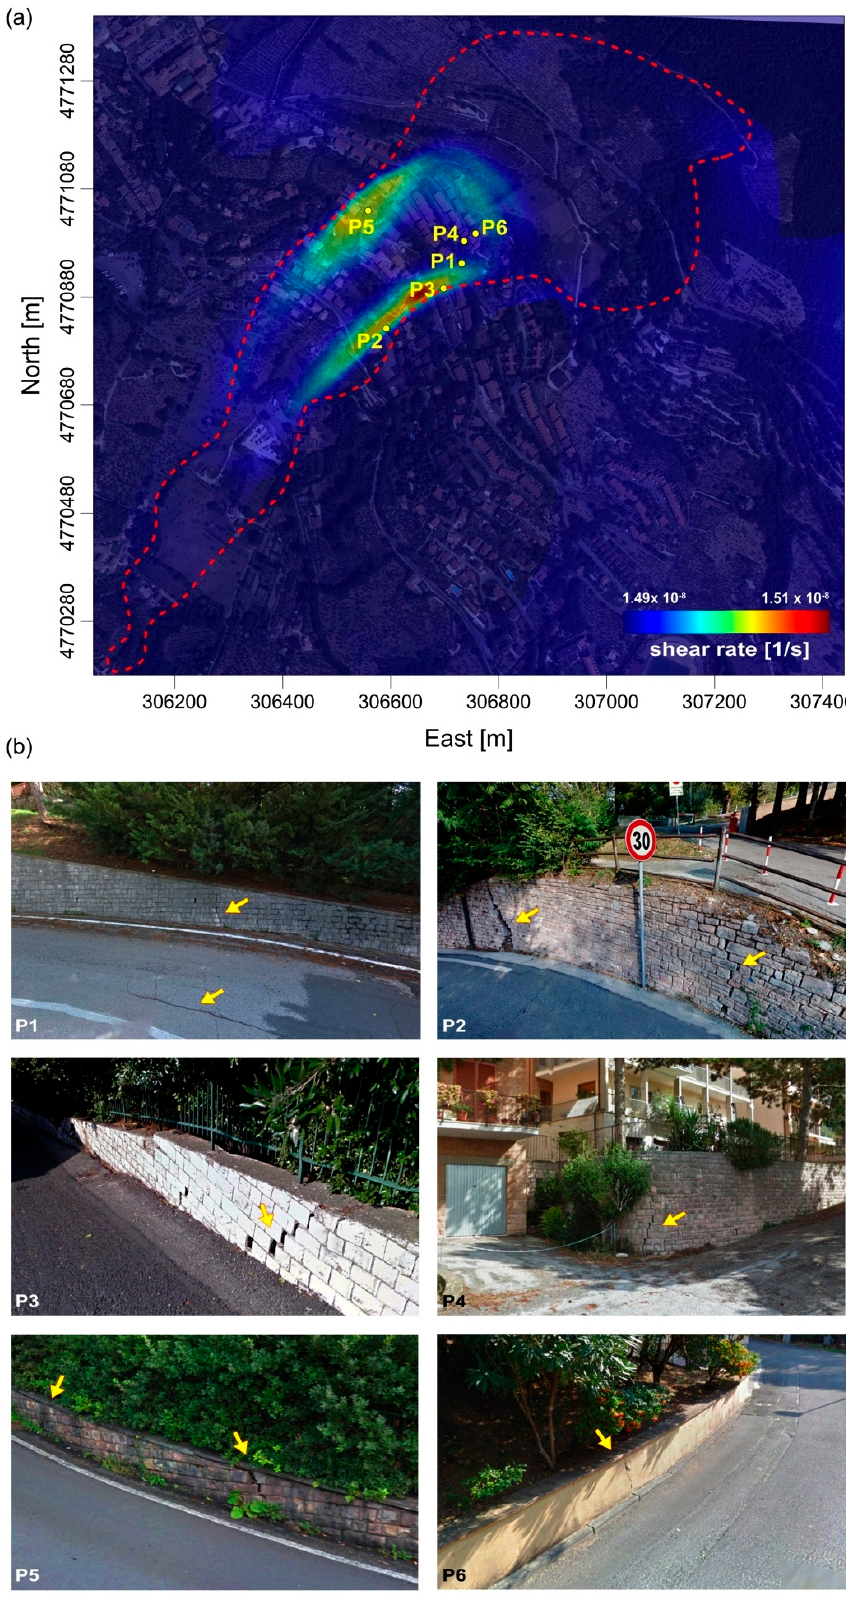
Figure 7. Shear rate map and structure damage: ( a ) Shear map superimposed on the satellite optical image of the Ivancich surrounding area (source Google Earth); ( b ) The pictures of the structure damage indicated with labels P1, P2, P3, P4, P5, P6 are shown.